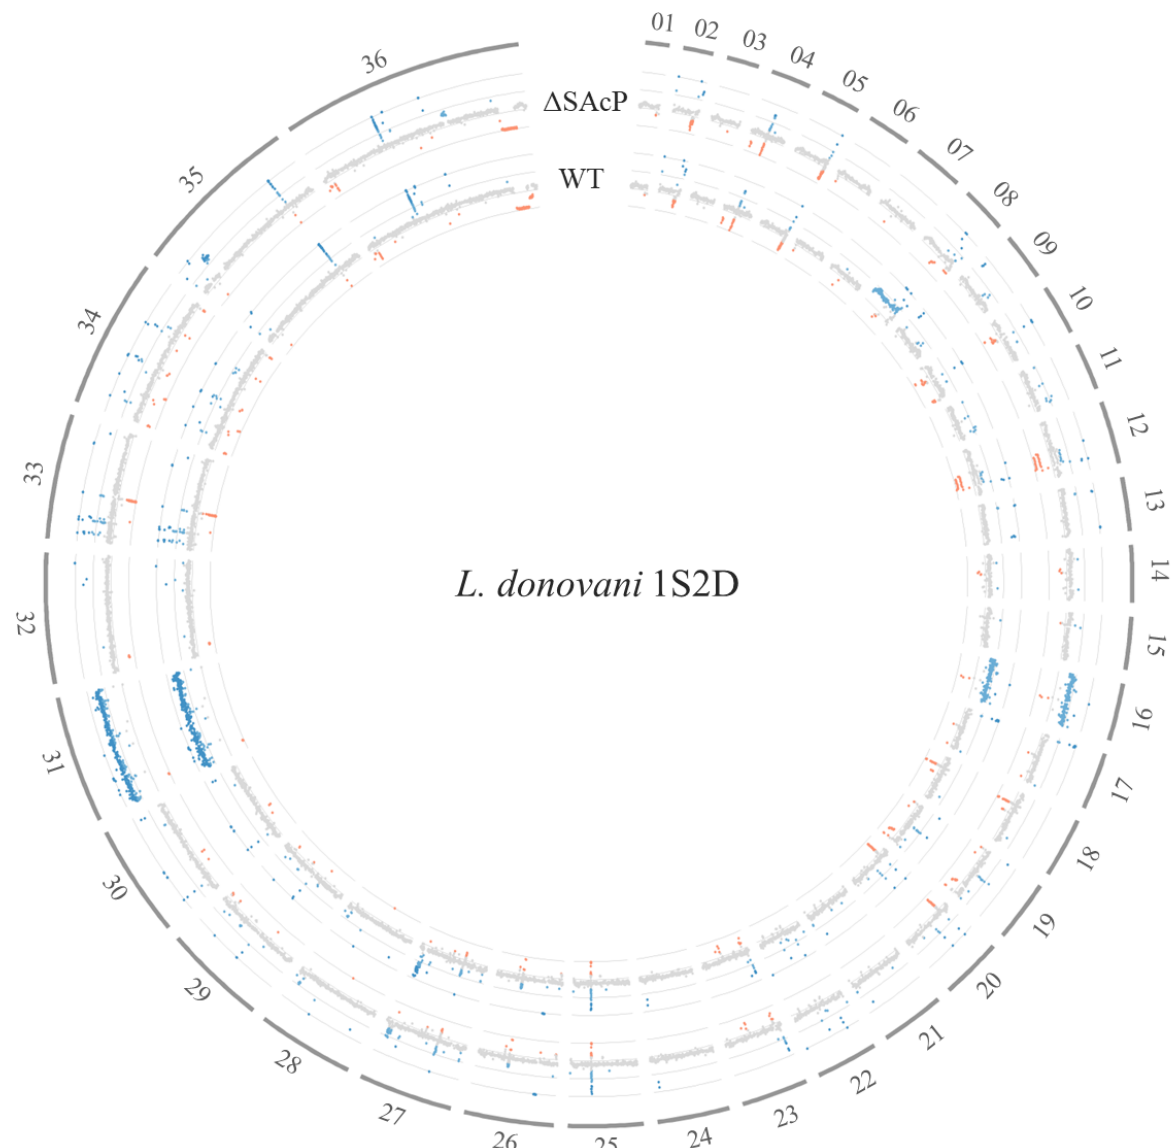
Figure 5. L. donovani wild type and mutant whole-genome chromosome analysis. L. donovani 1S2D wild type and L. donovani mutant Ld ∆ SAcP genomes were sequenced by Illumina, and the reads were aligned to the L. donovani CL-SL reference genome [23], and their coverages were analyzed using the module bedtools coverage. The mean coverage for each gene is plotted along the reference genome from chromosome 1 to 36, and Ld ∆ SAcP coverage is normalized to LdWT coverage. Mean coverage is grey, increased copy numbers is blue and decreased copy numbers is red. The inner circle is the L. donovani wild type (WT) and the outer circle is the mutant Ld ∆ SAcP genome. The average coverage across the entire genome serves as the baseline for diploid genes. Chromosome 35 contains an amplicon and chromosome 8 has reverted to diploid in the Ld ∆ SAcP genome.